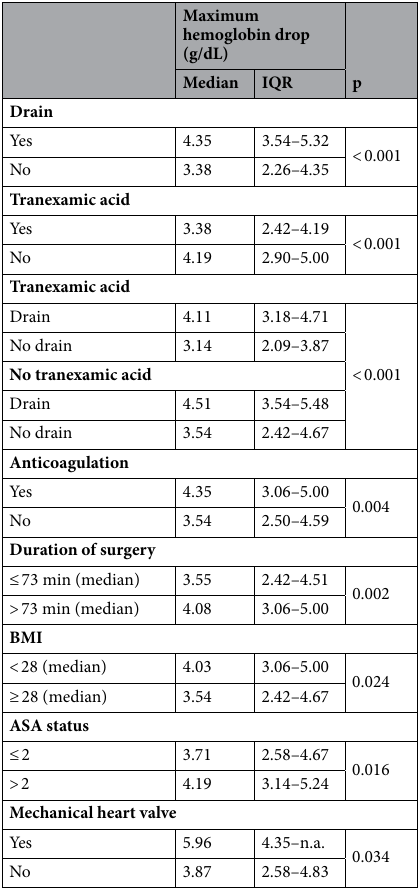
Table 2. Factors influencing the maximum drop in hemoglobin. BMI: body mass index, ASA: American Society of Anesthesiologists graden, n.a.: not applicable.